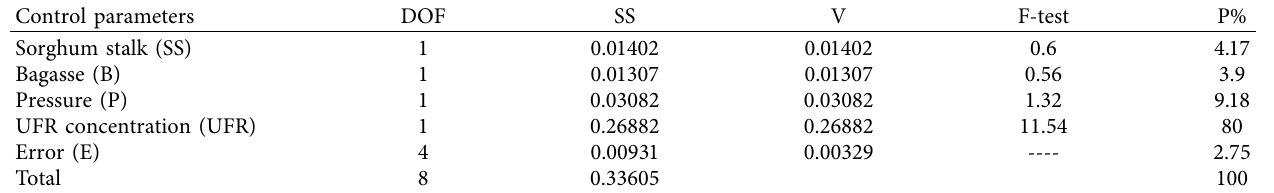
Table 5: ANOVA results for internal bonding strength